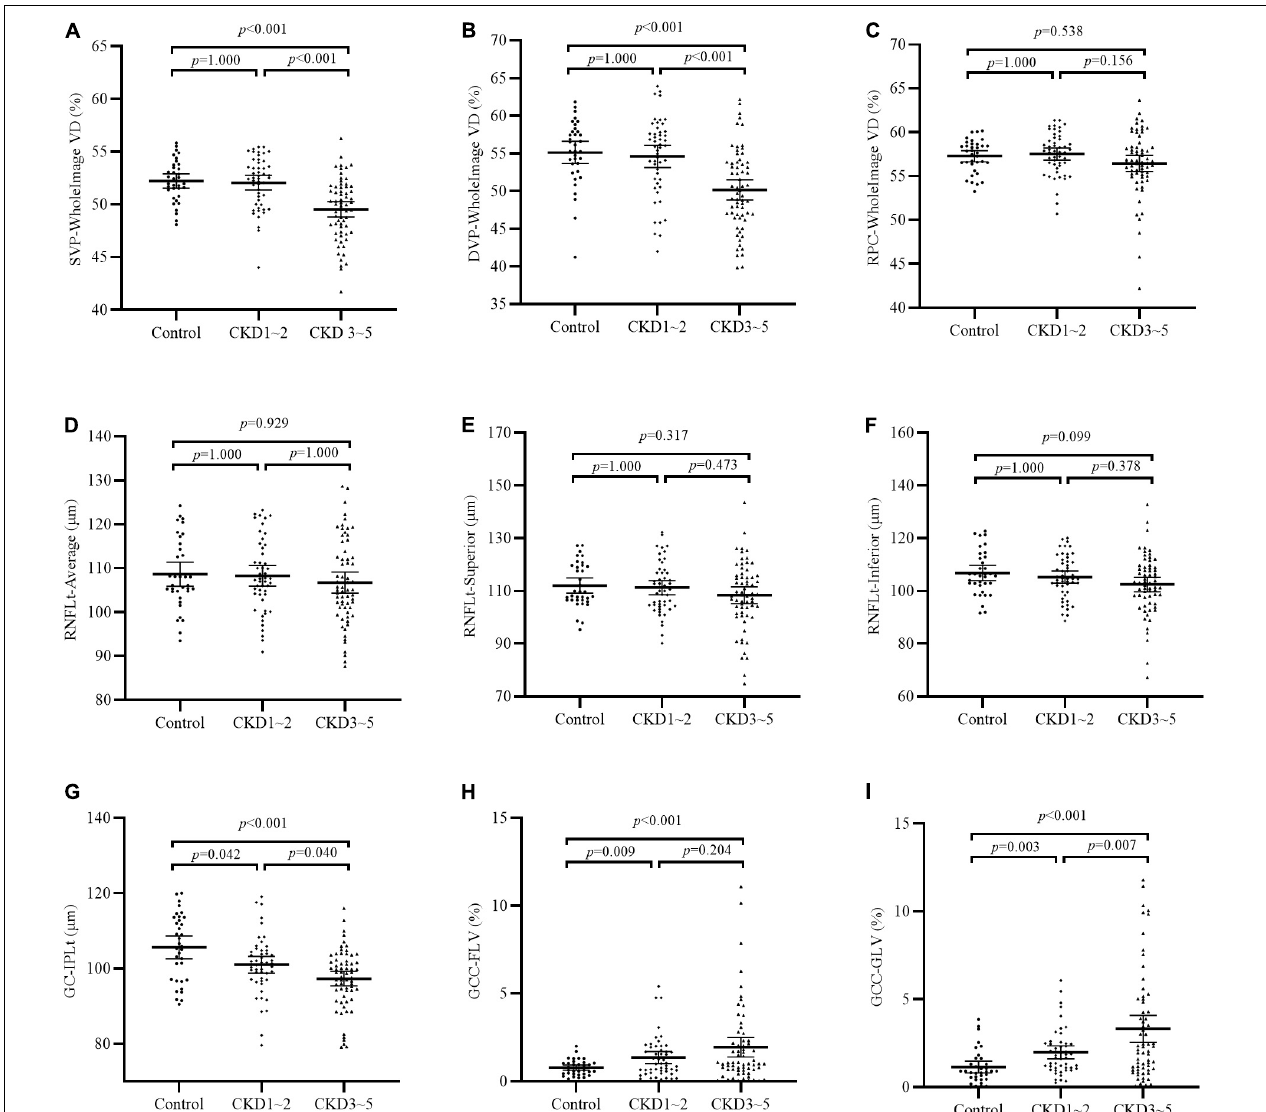
FIGURE 1 | Comparison of OCTA parameters among the three groups. (A–C) VD of SVP-WholeImage, DVP-WholeImage, and RPC-WholeImage among three groups; (D–F) Thickness of RNFL-Average, RNFL-superior, and RNFL-inferior among three groups; (G) Thickness of GC-IPL among three groups; (H) Focal loss volume of GCC among three groups; (I) Global loss volume of GCC among three groups. CKD, chronic kidney disease; VD, vessel density; SVP, superficial vascular plexus; DVP, deep vascular plexus; RPC, retinal peripapillary capillary; RNFLt, retinal nerve fiber layer thickness; GC-IPLt, ganglion cell-inner plexiform layer thickness; GCC, ganglion cell complex; GLV, global loss volume; FLV, focal loss